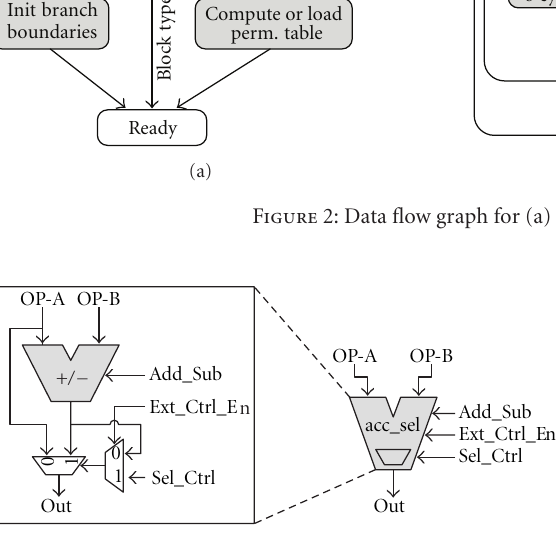
Figure 3: An accumulation and selection cell (acc